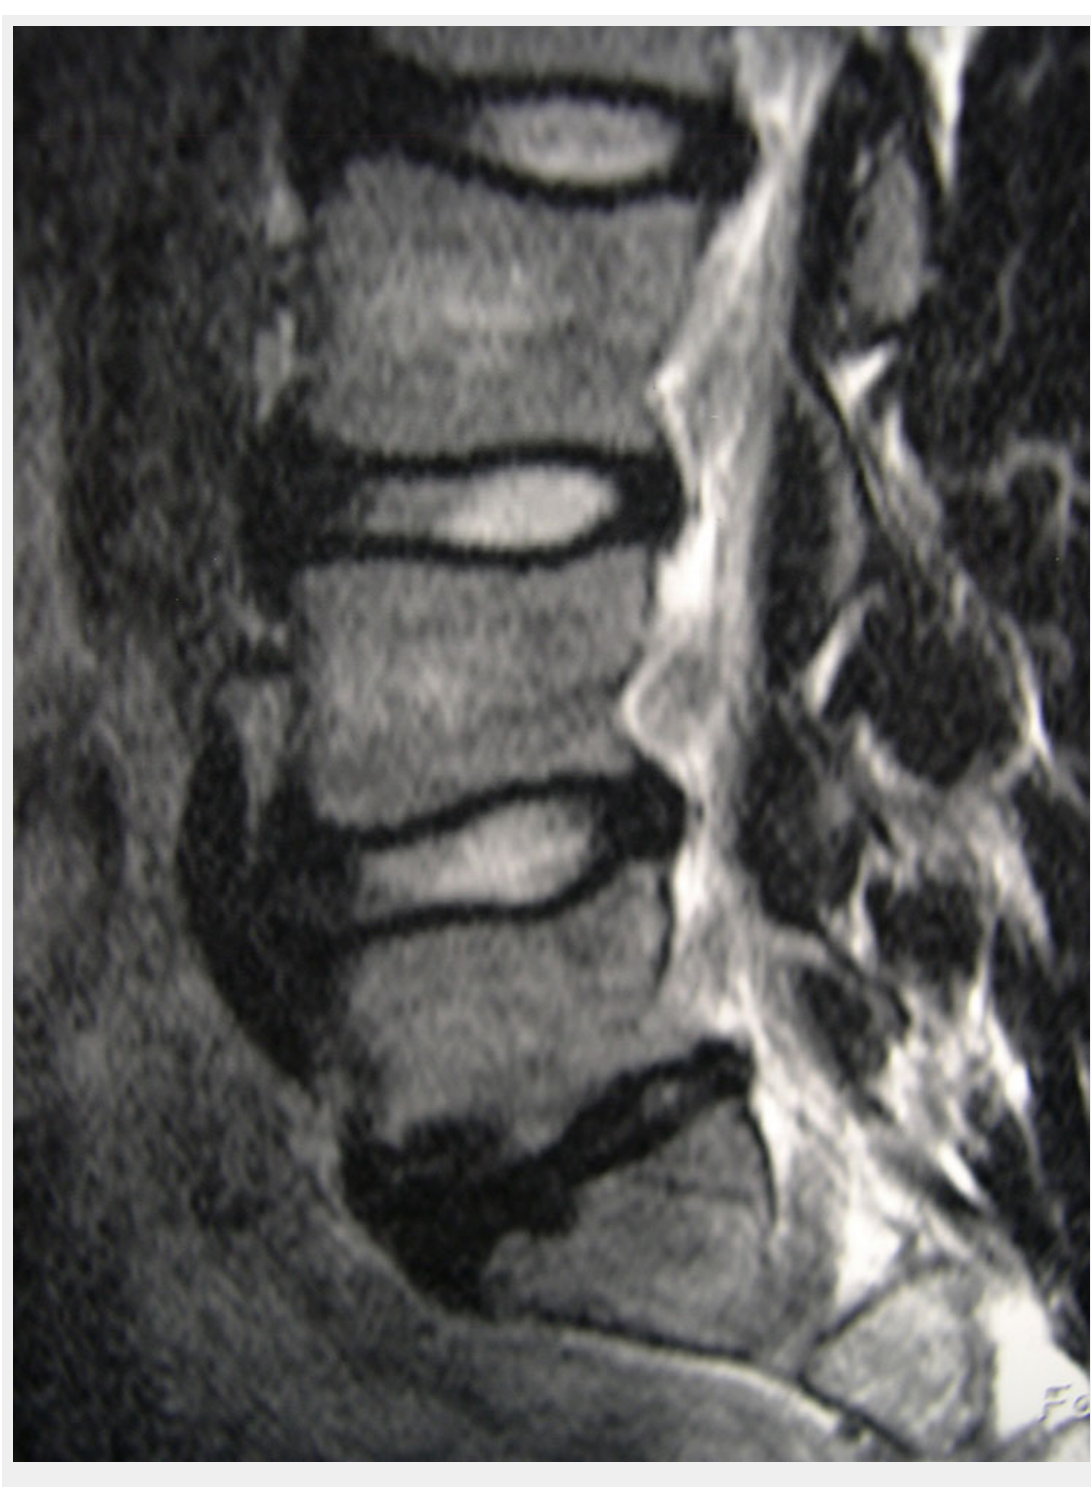
Figure 2 Lumbosacral stress response in a 14-year-old adolescent high level mountain bike downhill racer with a 12 month history of activity-related lumbar back pain which did not respond to physiotherapy. Refrain from sport, an intense physiotherapy programme and a lumbar brace led to complete pain relief. A standard lateral standing radiograph of the lower lumbar spine: Disk space narrowing at the level L5/S1. Endplate irregularities of the fifth lumbar vertebra and the first sacral vertebra. Normal sagittal spinal contour. The anteroposterior radiograph was found to be